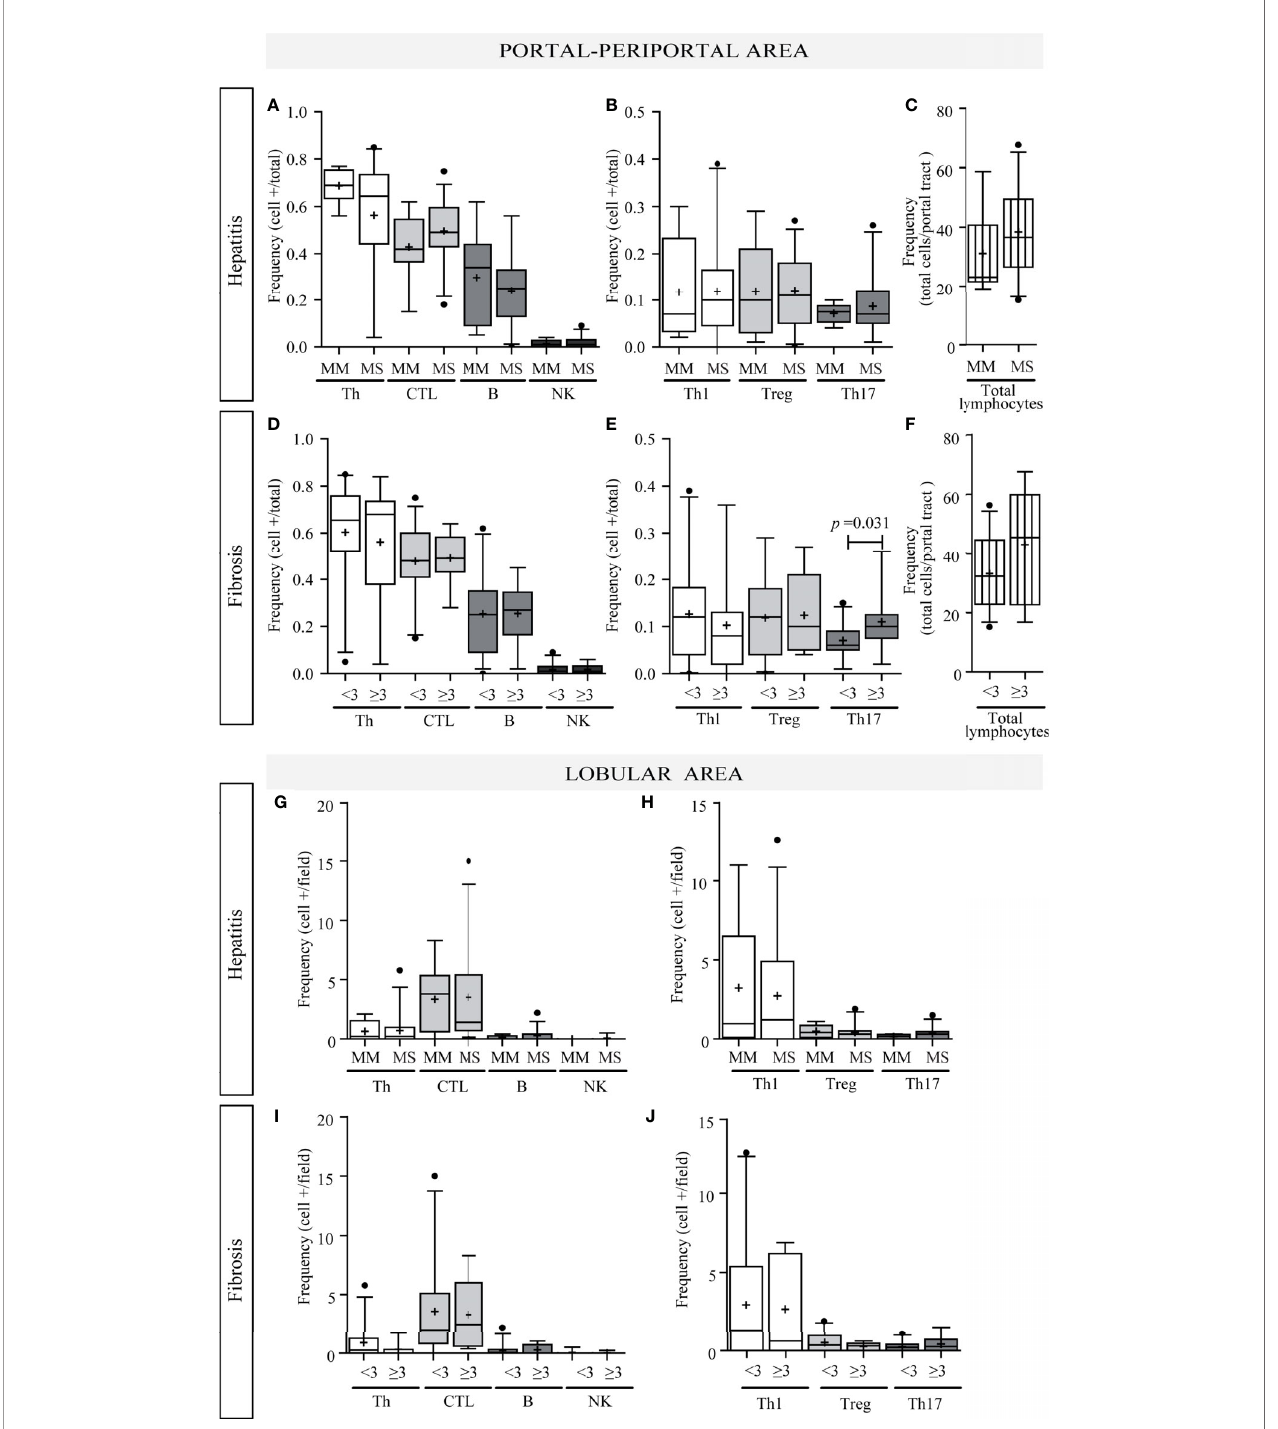
FIGURE 3 | Relationship between intrahepatic in fi ltrate and liver damage. Portal – periportal cell population frequencies related to hepatitis (A – C) and fi brosis severity (D – F) . Lobular cell population frequencies related to hepatitis (G, H) and fi brosis severity (I, J) . Th, CTL, B lymphocytes and NK cell (A, D, G, I) ; Th subpopulation (B, E, H, J) ; and total portal lymphocytes (C, F) . MM, minimal – mild; MS, moderate – severe hepatitis. Advanced fi brosis (F ≥ 3) according to METAVIR. The results are depicted in box plots. Horizontal lines within boxes indicate medians. Horizontal lines outside the boxes represent the 5 and 95 percentiles. Mean is indicated as